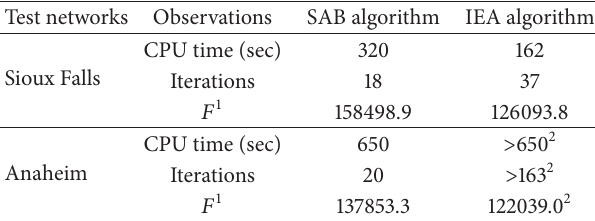
Table 1: Computational result test